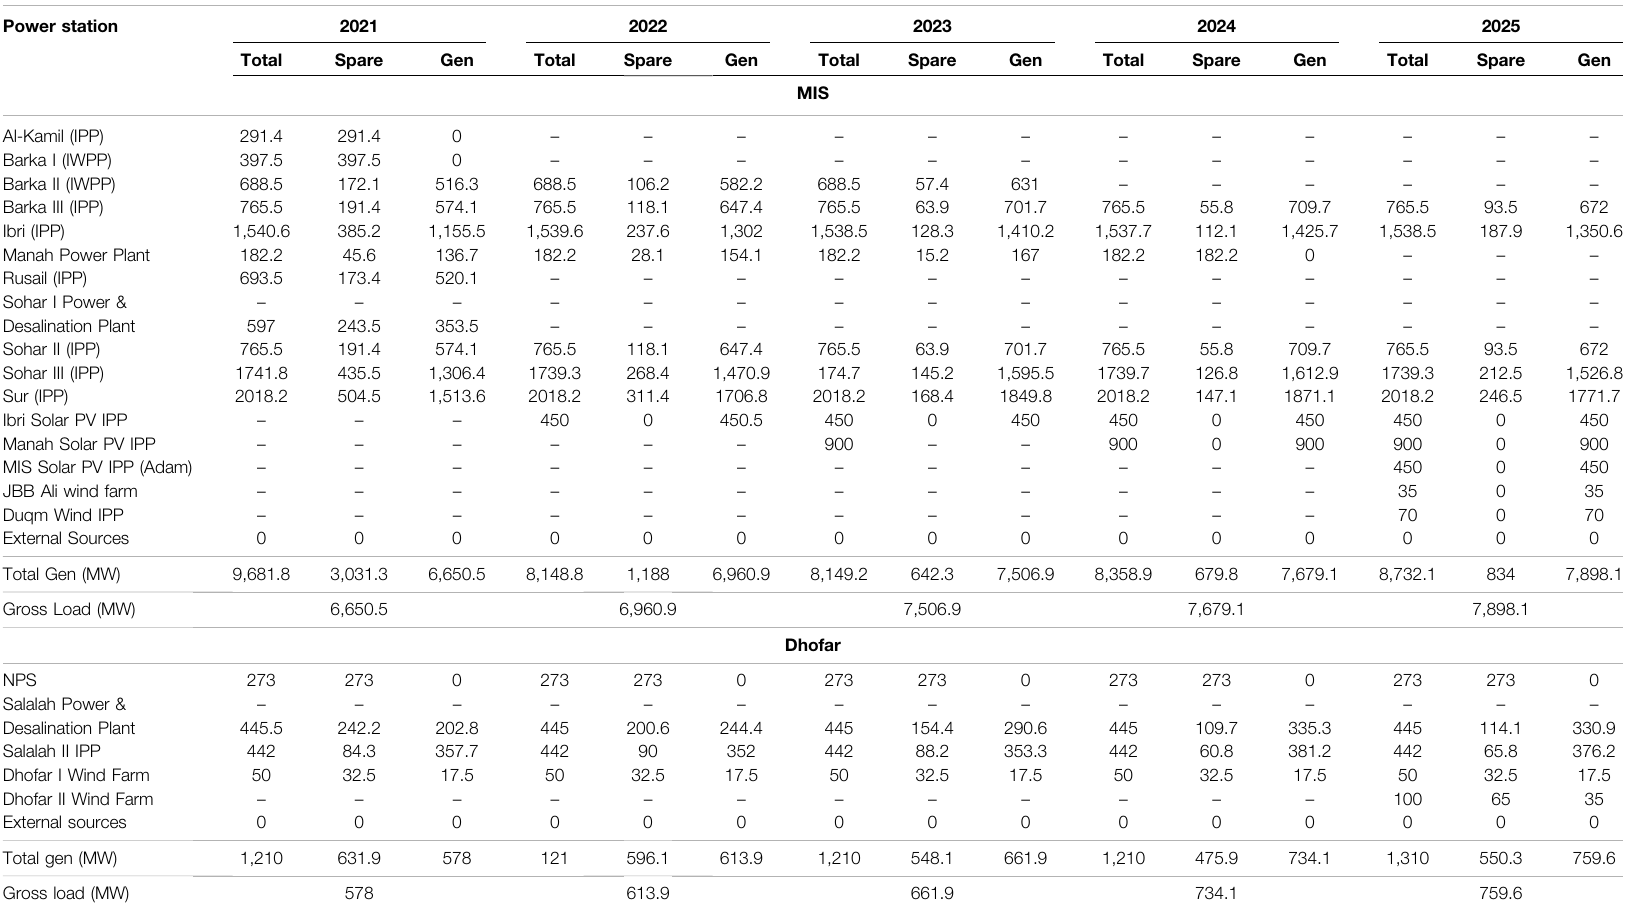
TABLE 3 | Summary of connected generation used in load fl ow studies of maximum demand. Power station